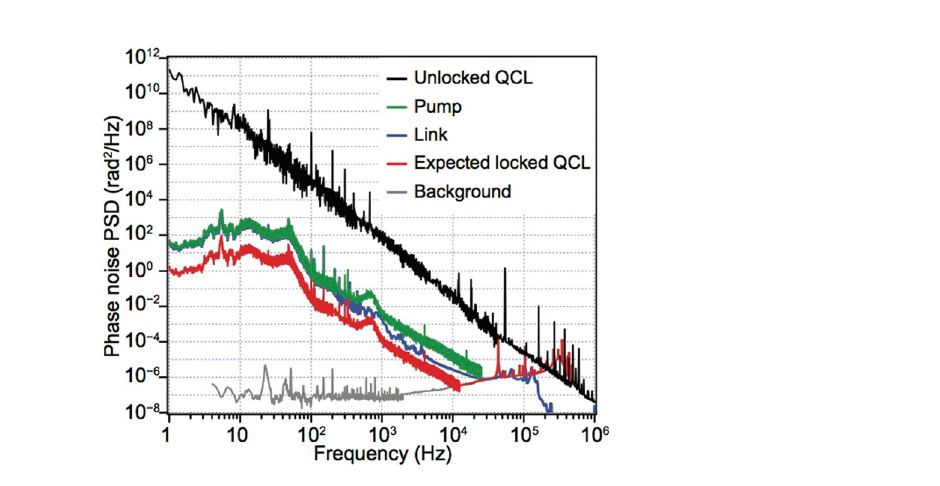
Figure 2. Phase noise of various components of the frequency locking chain. The phase noise of the free running QCL is shown in black. The noise on the fibre link is shown in blue. The error signal of the phase-lock loop for the pump laser is shown in green. The expected phase noise of the phase-locked QCL is shown in red and is obtained by scaling the phase noise of the pump laser, following the virtual beat note